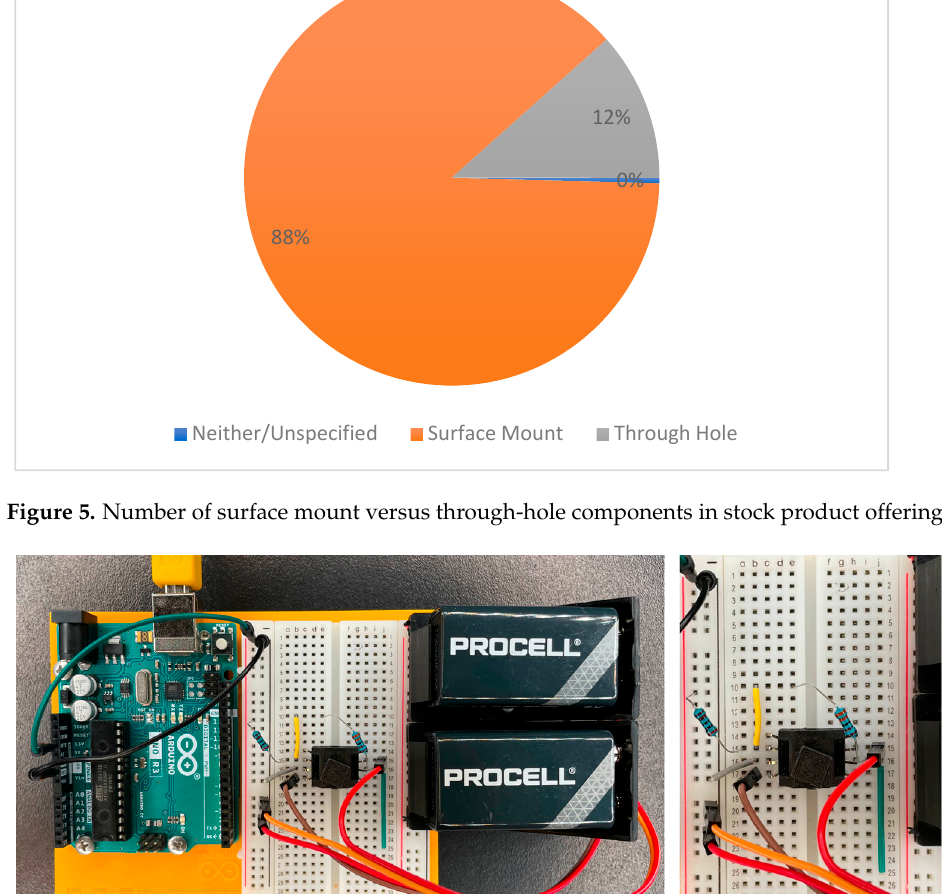
plifier. In relation to Figure 6: R fb = 3.3 k Ω , R input = 2 k Ω , and V input = +3.3 V;